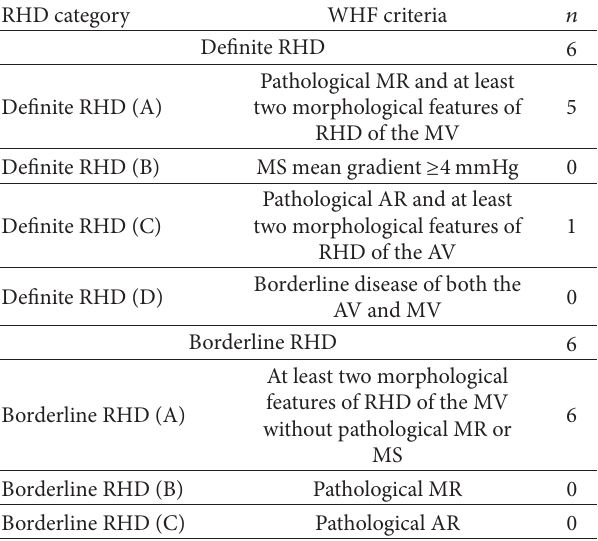
Table 3: Rheumatic heart disease classified according to World Heart Federation